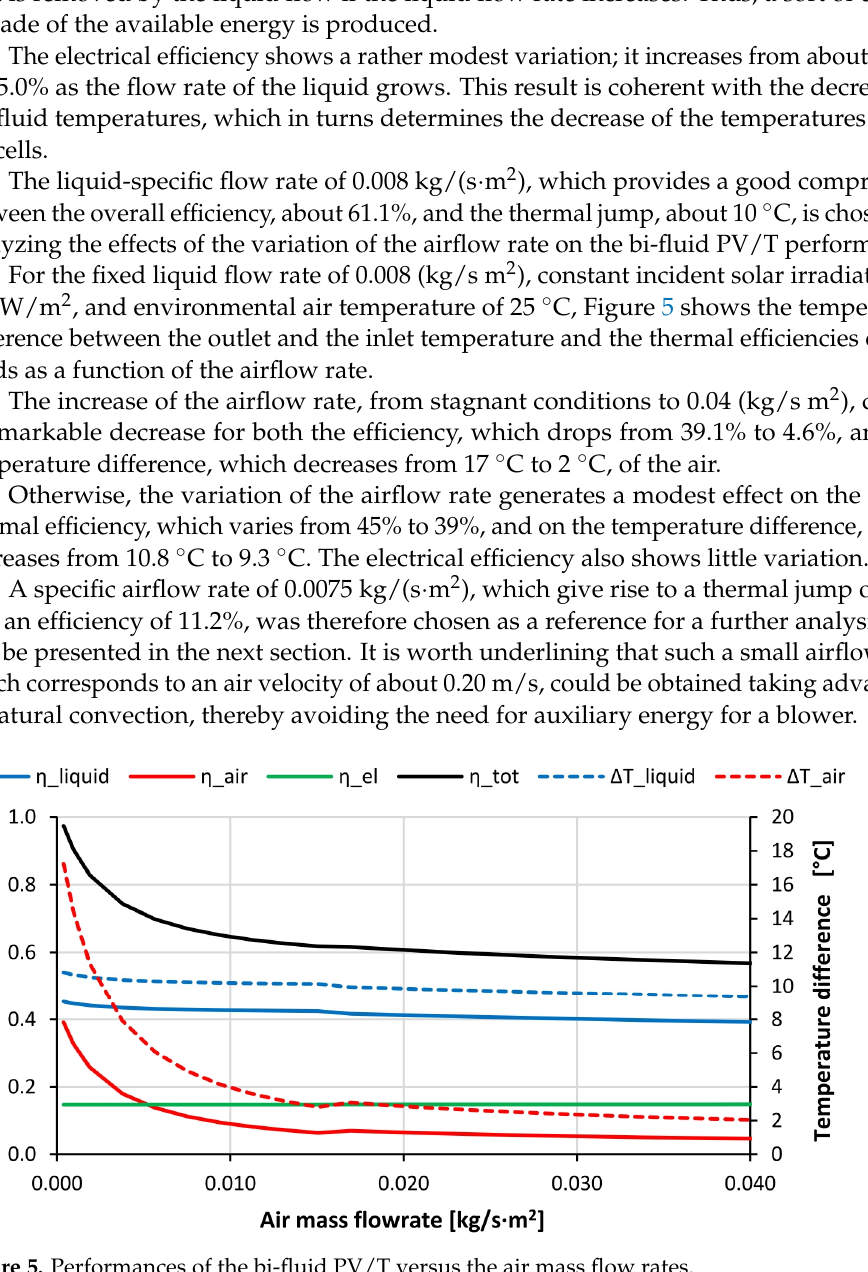
Figure 5. Performances of the bi-fluid PV/T versus the air mass flow rates.